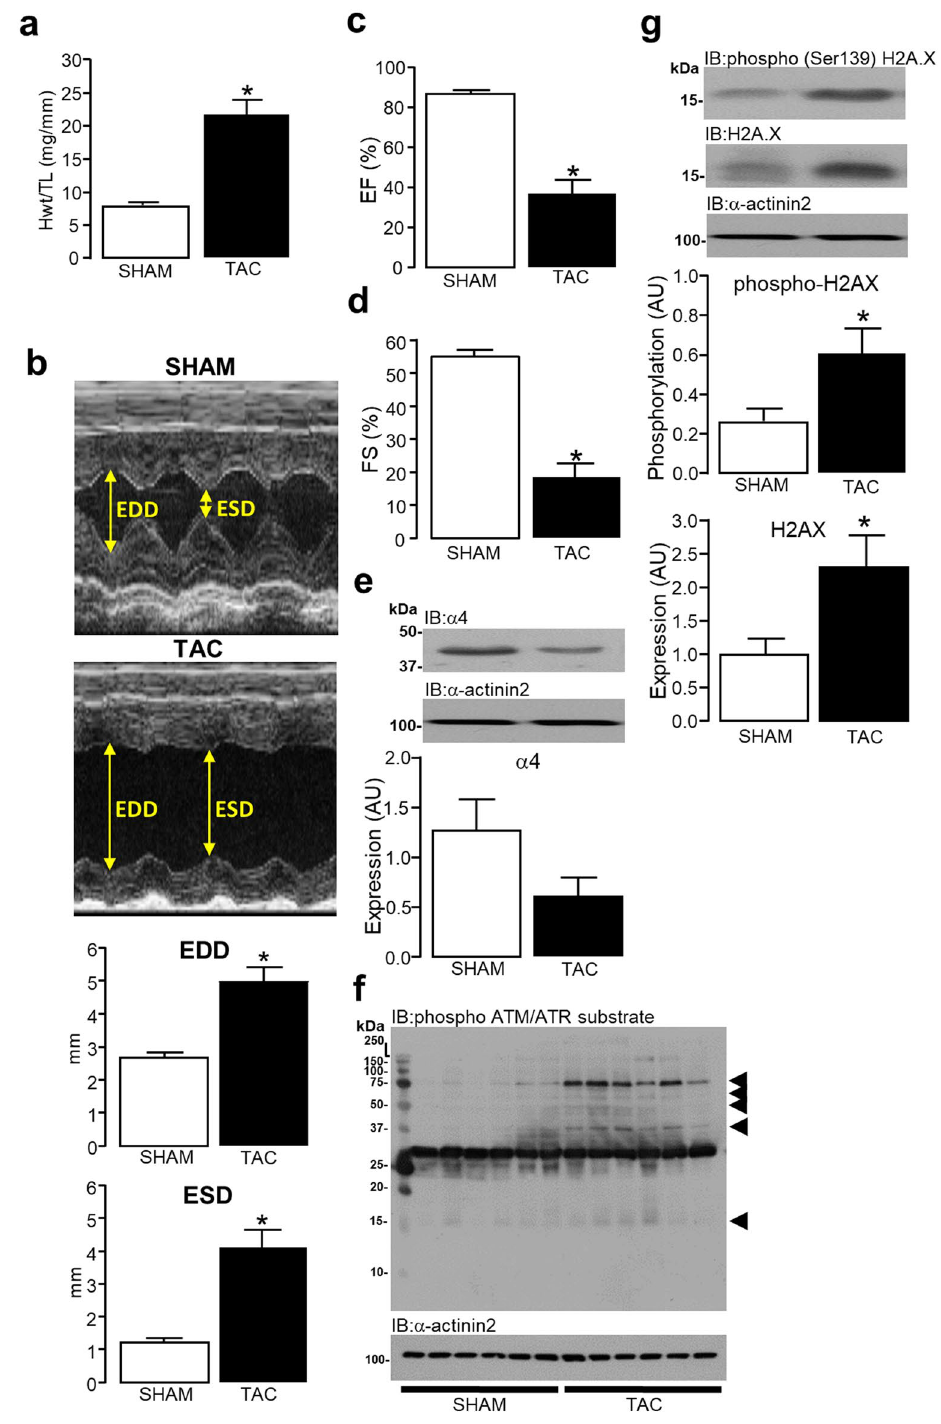
Figure 7. α4 protein expression and DNA damage in pressure overload-induced end stage heart failure. The hypertrophic growth of the heart in response to SHAM or pressure overload induced by transaortic constriction (TAC) for 9 weeks, is expressed as heart weight (mg) normalized to tibia length (mm) ( a ). M-Mode transthoracic echocardiography was used to determine diastolic (EDD) and systolic (ESD) dysfunction ( b ), ejection fraction ( c ) and fractional shortening ( d ) in hearts following 9 weeks of SHAM or TAC surgery. Expression of α4 protein ( e ), phosphorylated ATM/ATR substrates ( f ), H2AX and H2AX Ser139 phosphorylation ( g ) was determined in SHAM and TAC operated hearts by Western analysis using antibodies as described earlier. All data represents mean values ± SEM (6 SHAM/6 TAC) where statistical significance was determined where appropriate by a one or two-tailed Student’s T-test. Expression of α-actinin2 was used to confirm equal protein loading between